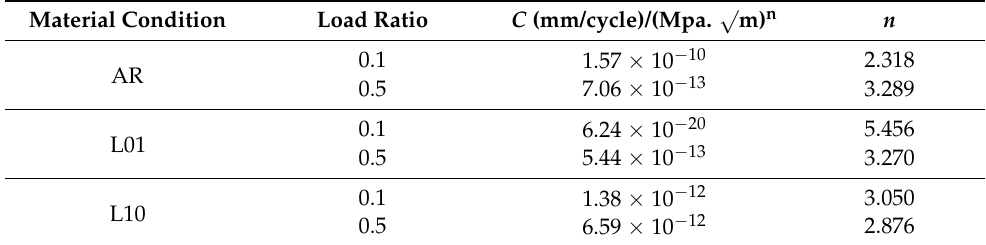
Table 1. Fitting parameters for the Paris